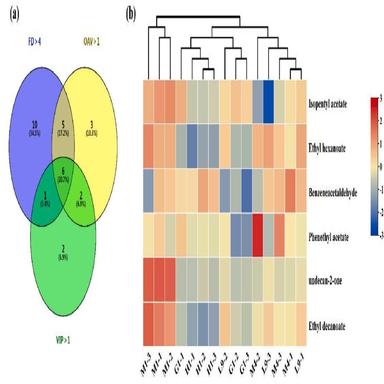
Screening of key compounds in 5 groups of Rice flavor baijiu. (a) Venn diagram; (b) Clustering heat map.